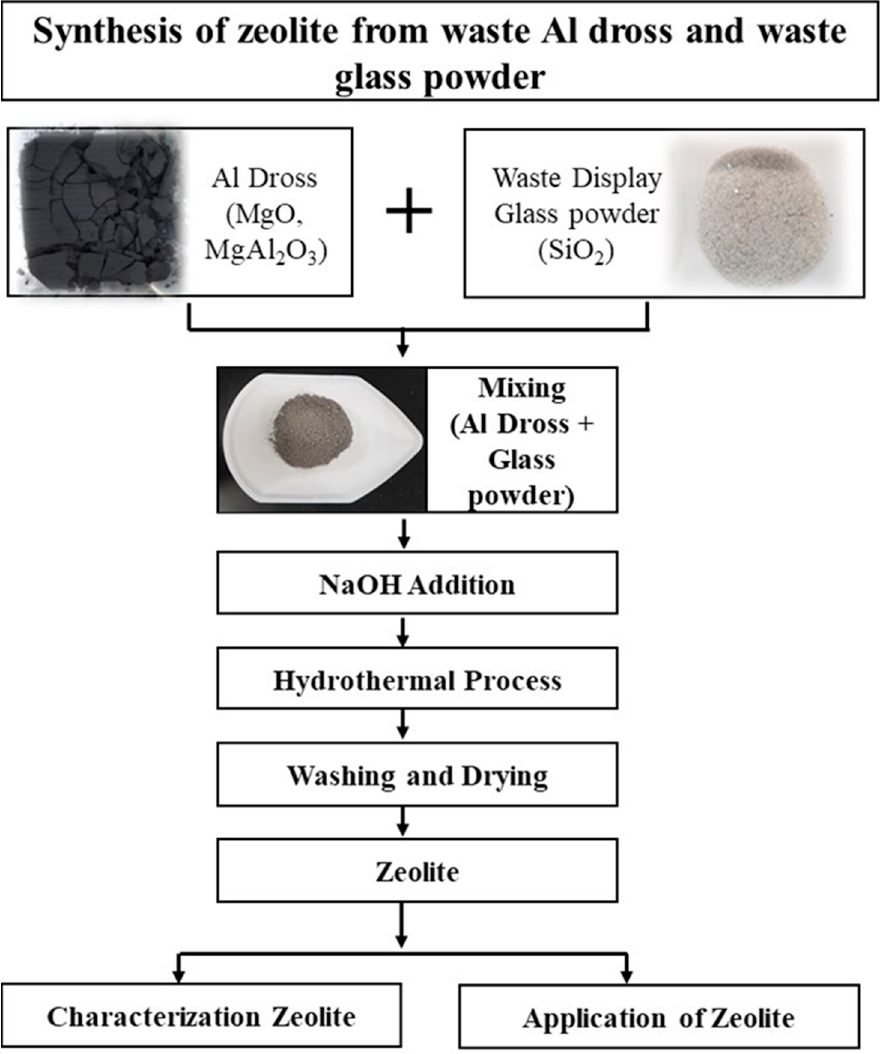
Figure 2. Experimental process followed for the synthesis of zeolite from the waste to waste stream combination.